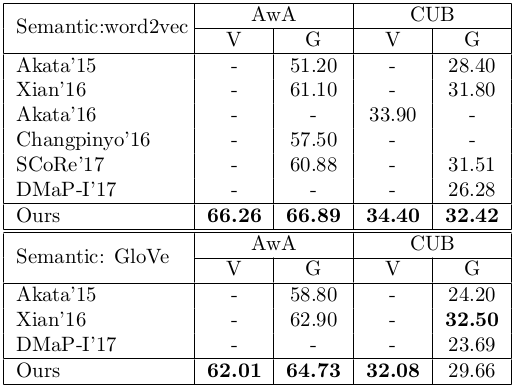
Table from the paper: A Unified approach for Conventional Zero-shot, Generalized Zero-shot and Few-shot Learning
Table text:
Semantic:word2vec
AwA
CUB
V
G
V
G
Akata’15
-
51.20
-
28.40
Xian’16
-
61.10
-
31.80
Akata’16
-
-
33.90
-
Changpinyo’16
-
57.50
-
-
SCoRe’17
-
60.88
-
31.51
DMaP-I’17
-
-
-
26.28
Ours
66.26
66.89
34.40
32.42
Semantic:GloVe
AwA
CUB
V
G
V
G
Akata’15
-
58.80
-
24.20
Xian’16
-
62.90
-
32.50
DMaP-I’17
-
-
-
23.69
Ours
62.01
64.73
32.08
29.666